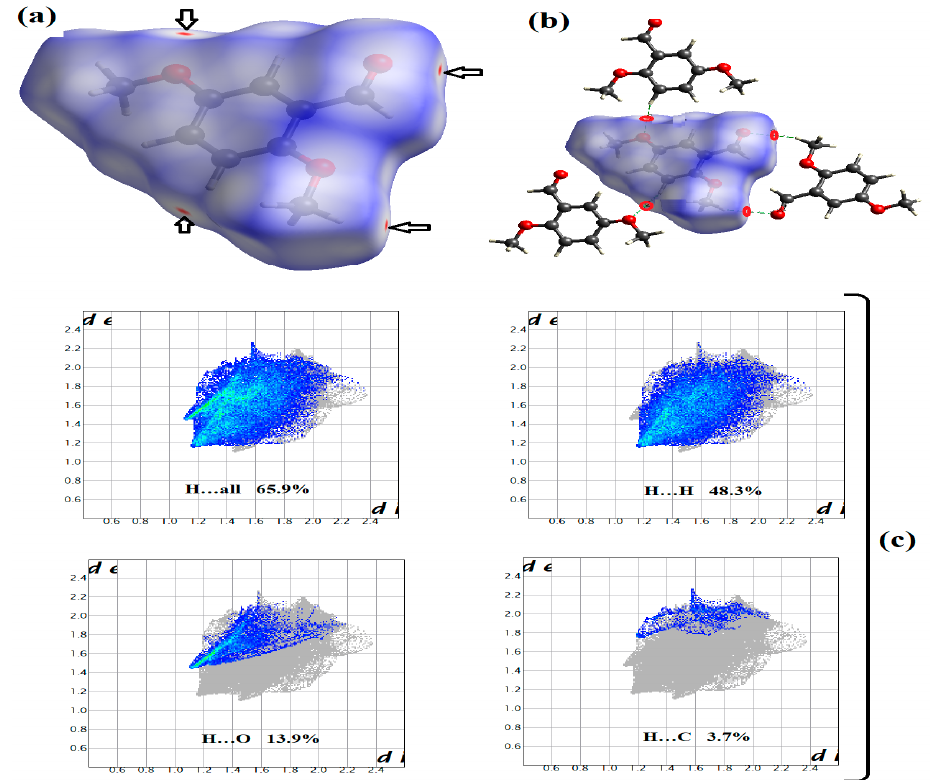
Figure 6. ( a ) Map of the d norm surface of the computed molecule. ( b ) Hydrogen bonding interactions of the computed molecule with its neighboring molecules. ( c ) Hirshfeld surface analysis (HSA) 2D fingerprint plots indicating the H ··· H, H ··· O, and H ··· C hydrogen-bonding interactions.